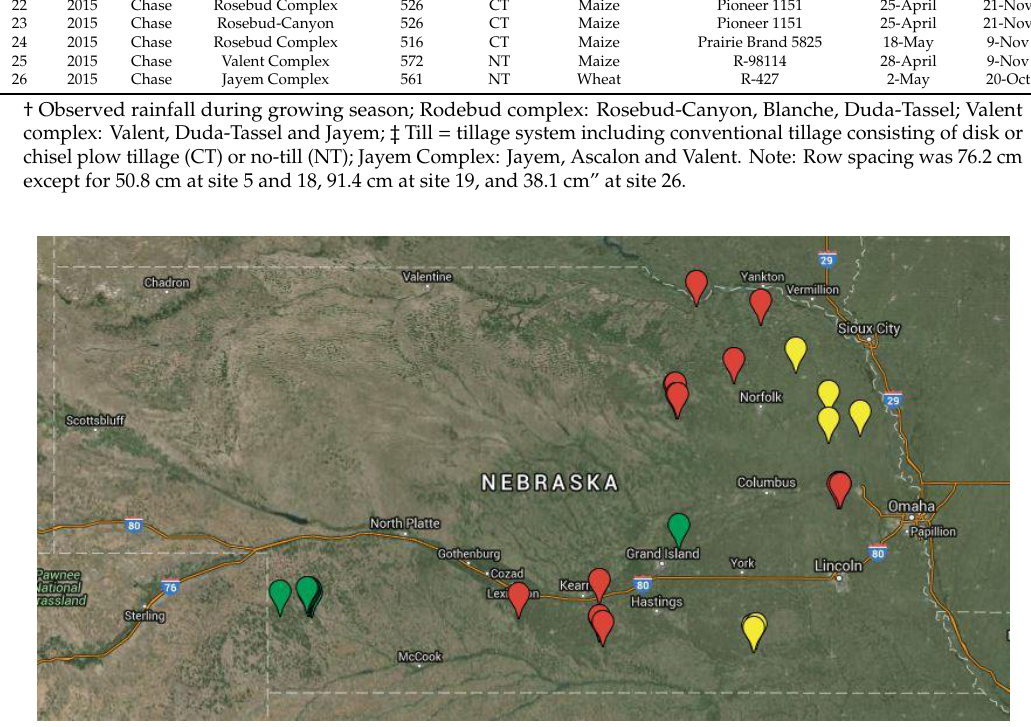
Figure 1. Sites of the 26 on-farm strip trials color coded by year. (2013: yellow, 2014: red, 2015: green) for the study of maize response to foliar application of micronutrients. Table 1. Site background information and cultural practices for 26 field strip trials testing foliar micronutrient application for irrigated maize but for popcorn at site 25 and 26. Site Year